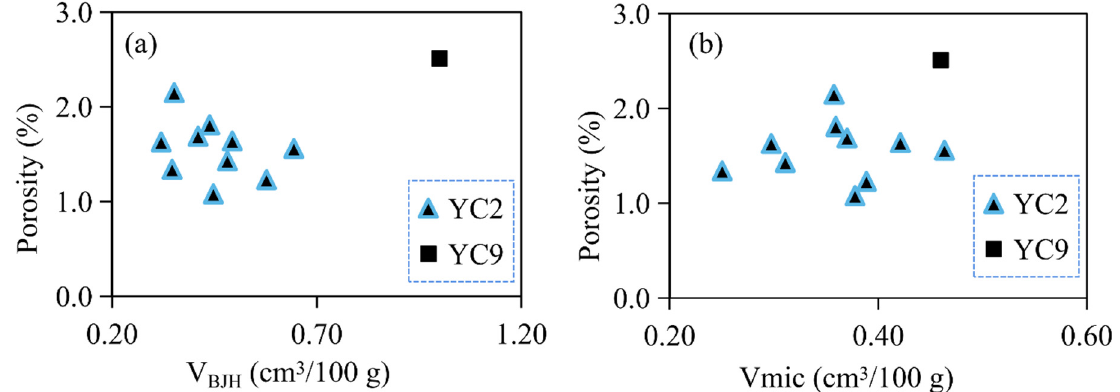
Figure 11. Relationships of porosity with V BJH ( a ) and Vmic ( b ) for samples.